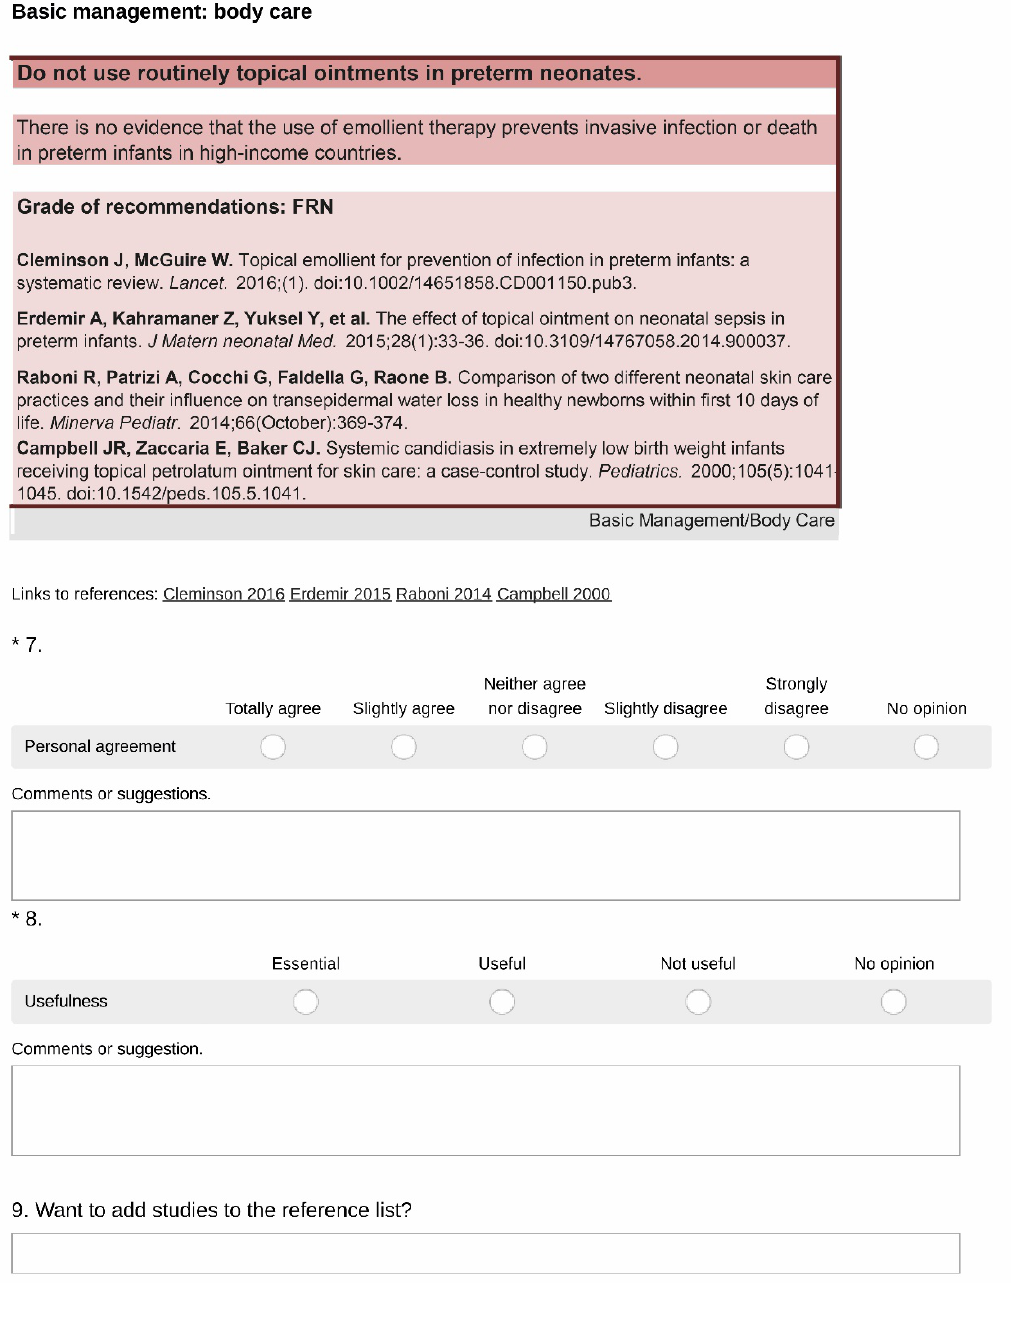
FIGURE A2-2 Layout of a question in the 1 st round of Delphi Explicative text provided to the experts in the 2 nd round of Delphi: What was done after the 1st round of Delphi? After the first round of Delphi, items were selected based on experts’ opinion (23 experts). The items on which at least 65% of the experts either totally agreed with or slightly agreed with were selected for 2nd round. A total of 145 of the 158 items were selected for the 2nd round or Delphi. Comments made on the main statements of items were used to modify some of them. Other comments will be taken into account and answers at the end of the Delphi